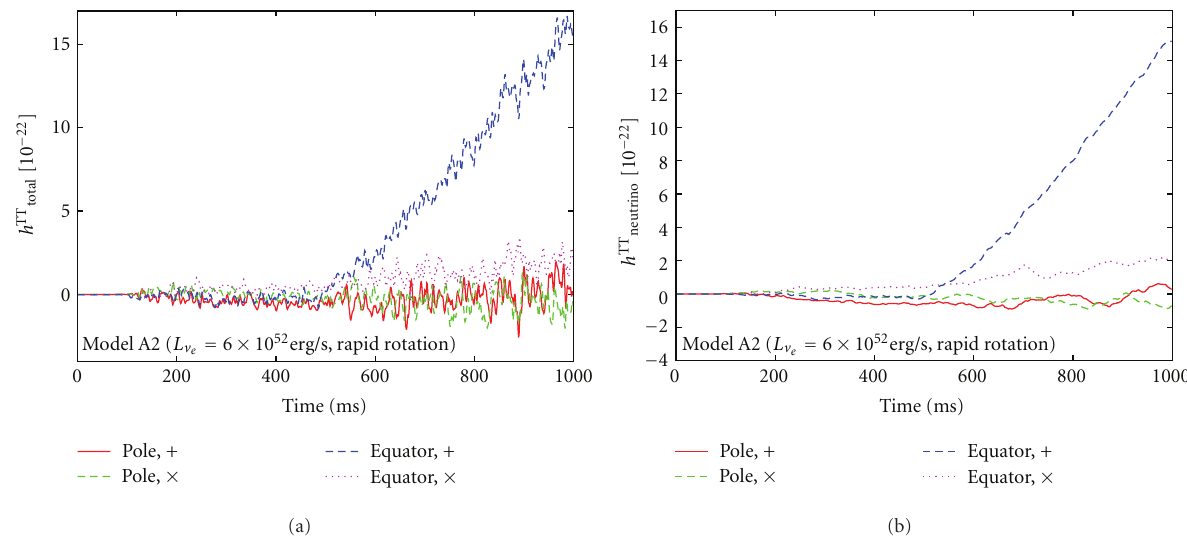
Figure 11: Gravitational waveforms from the sum of neutrinos and matter motions (left) and only from neutrinos (right) for a 3D model with rotation (from [210]). The time is measured from the epoch when the neutrino luminosity is injected from the surface of the neutrino sphere. For this 3D model with rotation, the rotational flow is imposed to advect to the PNS surface at around t = 400 ms. The supernova is assumed to be located at the distance of 10kpc.